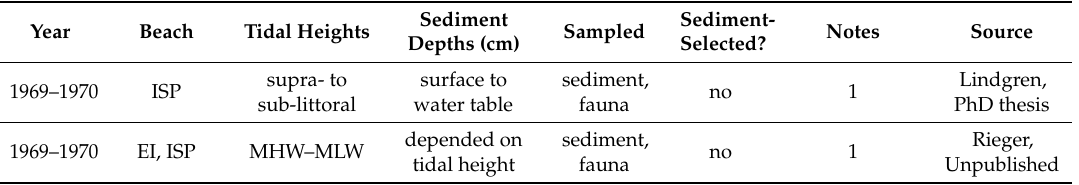
Table 1. Summary of the individual characteristics of the multiple meiofauna sampling projects conducted on Bogue Banks beaches that are reported in this study. Beaches: EI—Emerald Isle; ERBA—Eastern Regional Beach Access; FM—Fort Macon; SR—Spinnaker’s Reach; ISP—Iron Steamer Pier; PKS—Pine Knoll Shores; BI—Bear Island (not located on Bogue Banks). Tidal